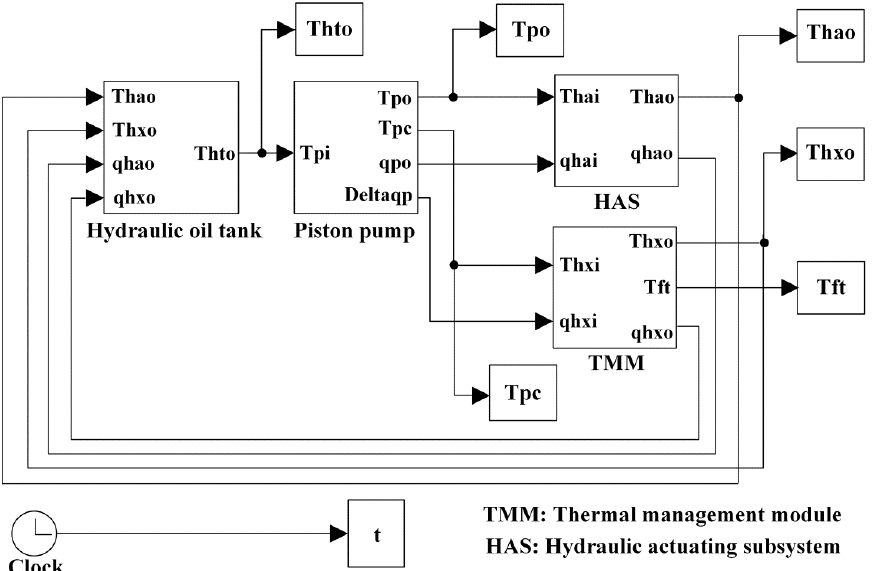
Figure 7. Element-level simulation model diagram of hydraulic system.